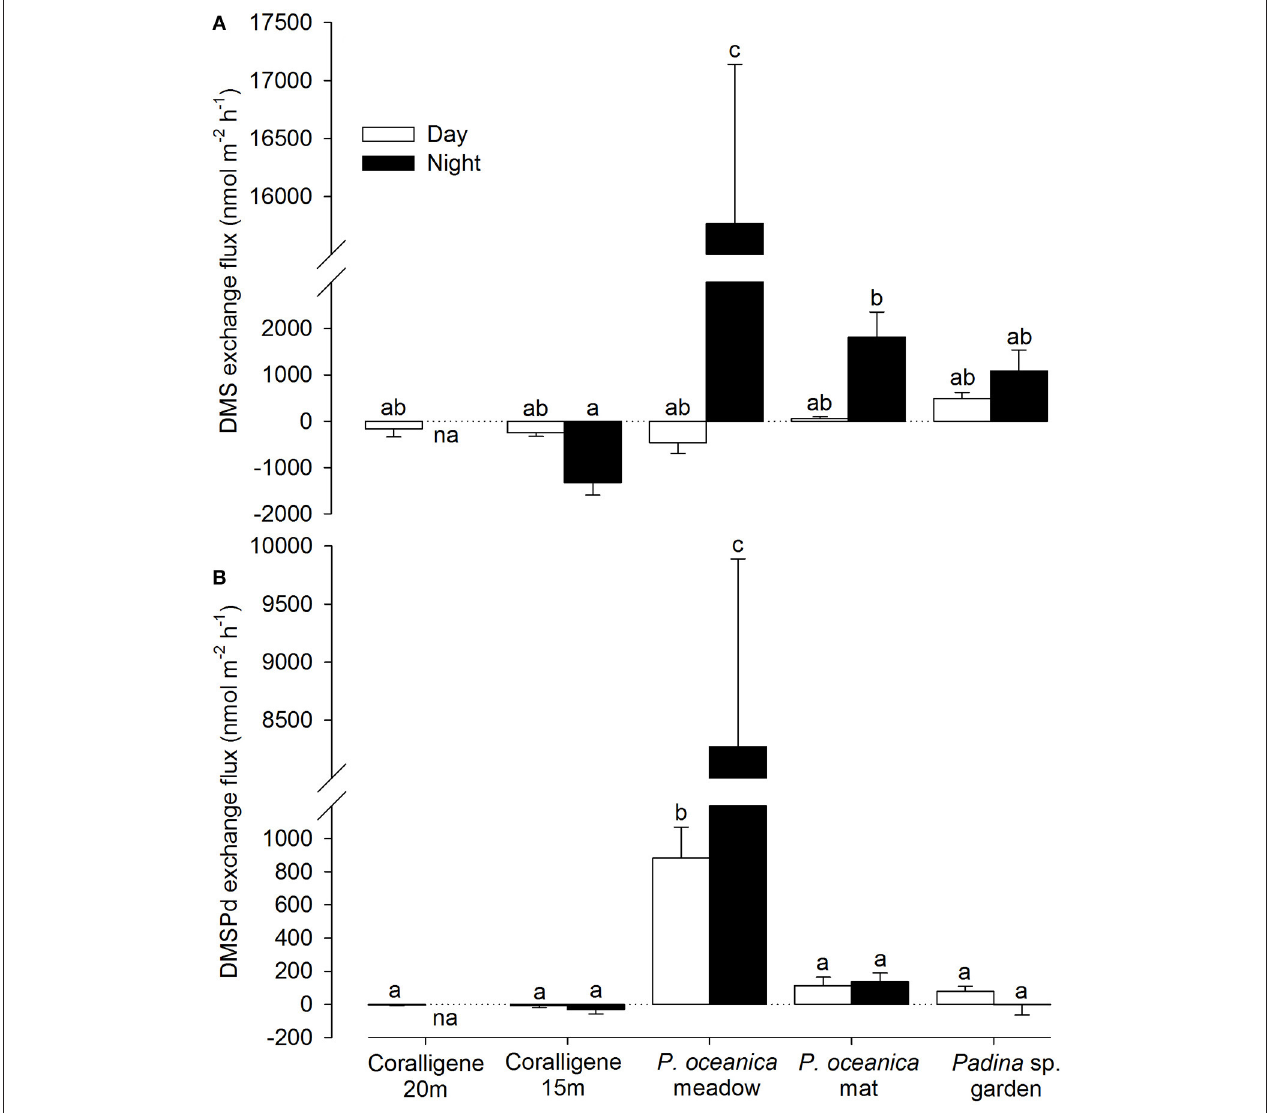
FIGURE 1 | Community-level exchange flux of dimethylated sulfur from key Mediterranean benthos. Net exchange flux in (A) DMS and (B) dissolved DMSPd (DMSPd) from coralligene, Posidonia oceanica meadows and dead mats and Padina sp. garden communities during the day (white bars) and night (black bars). Data presented as mean ± SE. Bars with different letters a-c are statistically different in net concentration change at p < 0.05. na = data not available. Positive flux indicates a net release from the